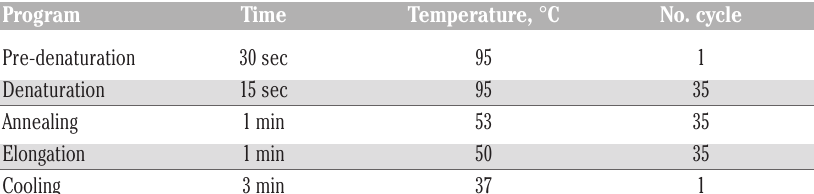
Figure 2. Electrophoresis gel agarose of cDNA real time polymerase chain reaction with ZmDBP2 primer. A) Sample from the field, B) control. M: Marker (1000 bp), 1: Rubby Brown Cob, 2: Red Blood, 3: Waxy, 4: Early Maturing Yellow, 5: Deep Yellow, 6: White, 7: Srikandi (reference Table 1. Program for real time polymerase chain reaction.